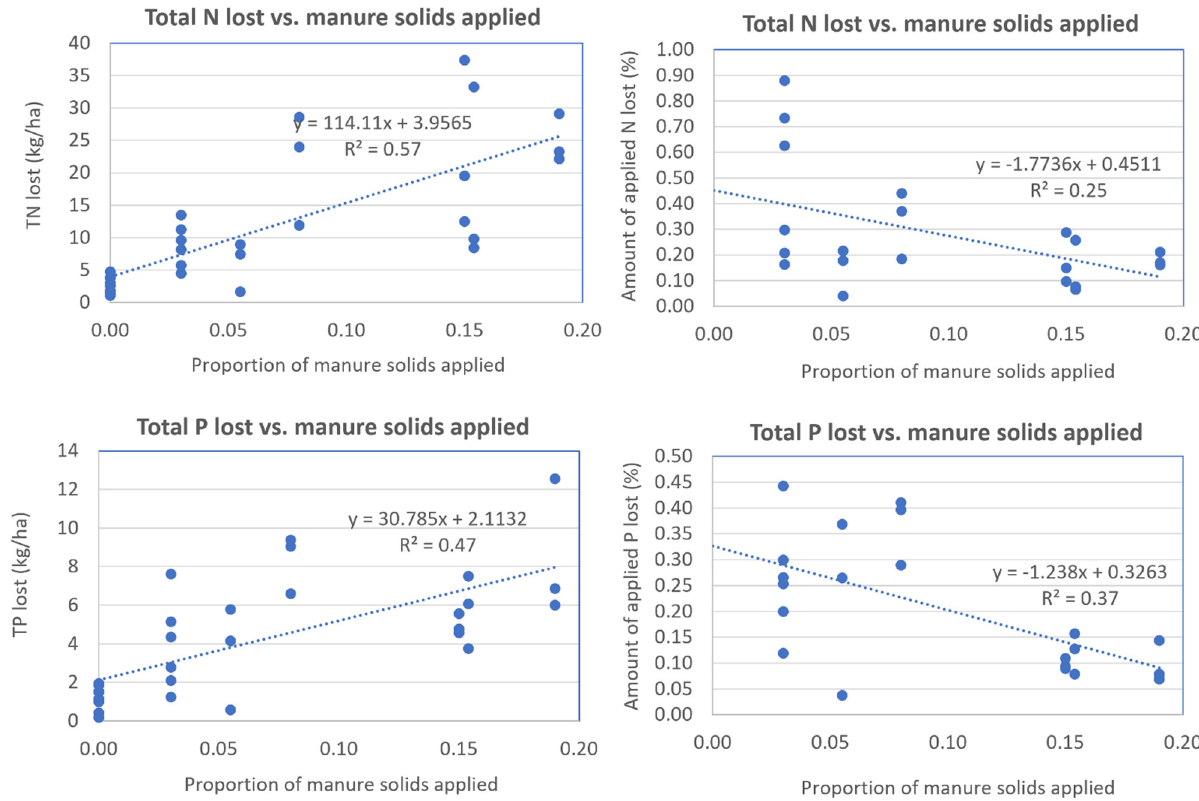
Figure 9. Cumulative snowmelt runoff losses of total N (TN) and total P (TP) and the fraction of manure-applied TN and TP lost in runoff as a function of the proportion of manure solids applied across site-years.